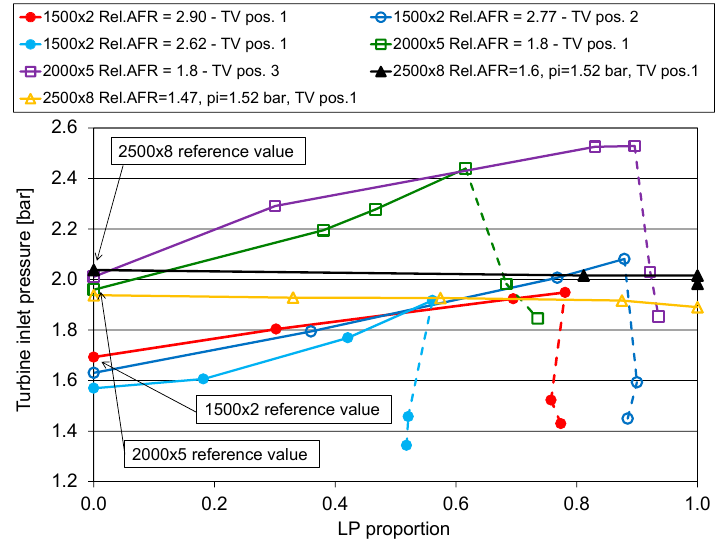
Figure 12. Turbine inlet pressure as a function of LP proportion in different operating modes.